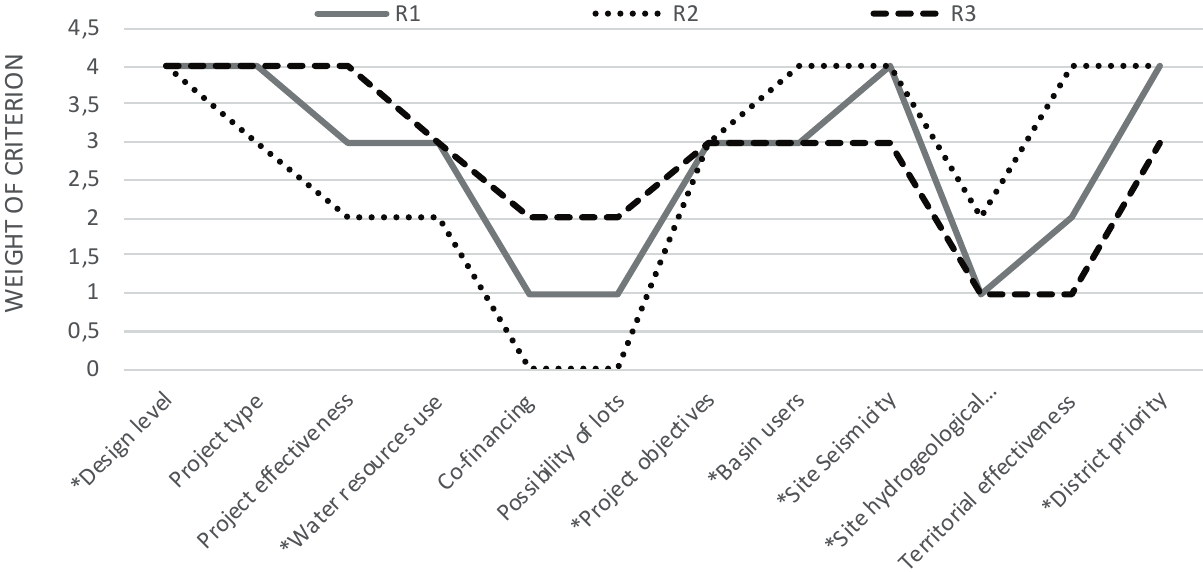
Figure 2. Graphic representation of the different weights of the criteria between the two tests and the assignment of the Technical Commit- tee (*criteria mostly linked to the definitions reported in the reference law).